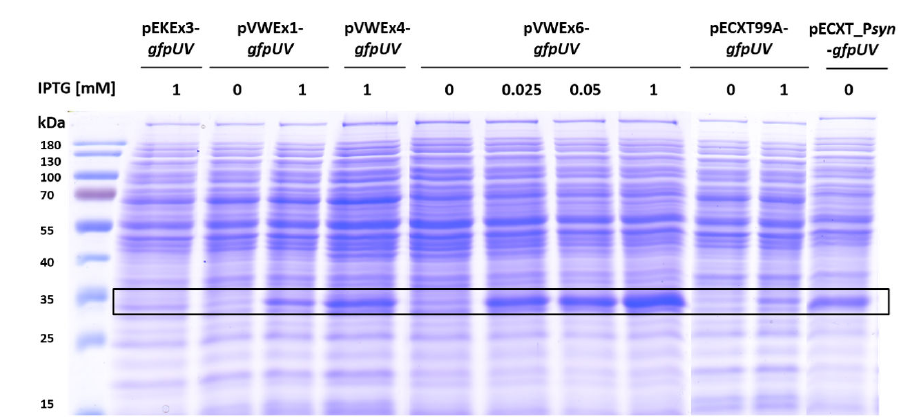
Figure 3. SDS-PAGE for comparison of GfpUV (27 kDa) protein abundance based on different expression vectors in C. glutamicum WT. 10 µ g of crude extracts from the main cultivation in CGXII with 4% glucose was loaded on a 10% SDS-PAGE. Pre-stained protein ladder (26616 from Thermo Scientific) was used as reference standard. Concentration of the inductor IPTG is given in